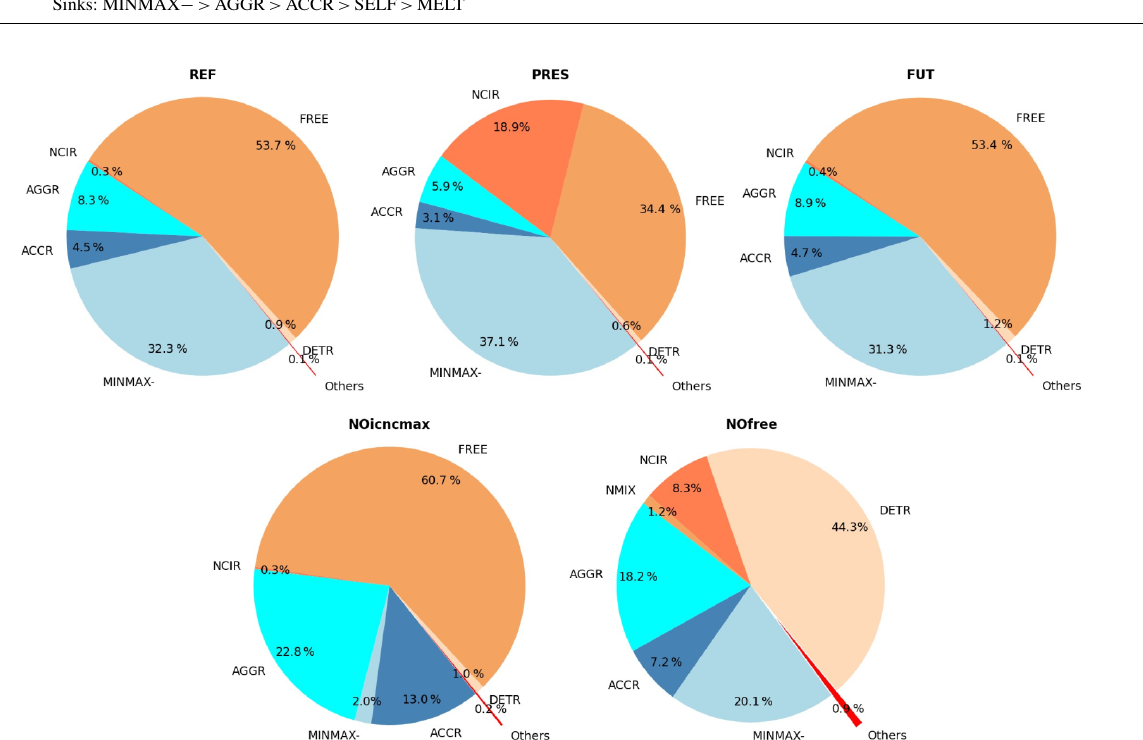
Figure 3. Relative contributions of the mean tendencies in Table 4. The sector “Others” of the pie charts includes NMIX, SECP, MELT, SELF, and MINMAX + (apart from NOfree, where NMIX is represented independently). Warm colour tones indicate sources of ICs, while cold colour tones indicate sinks of